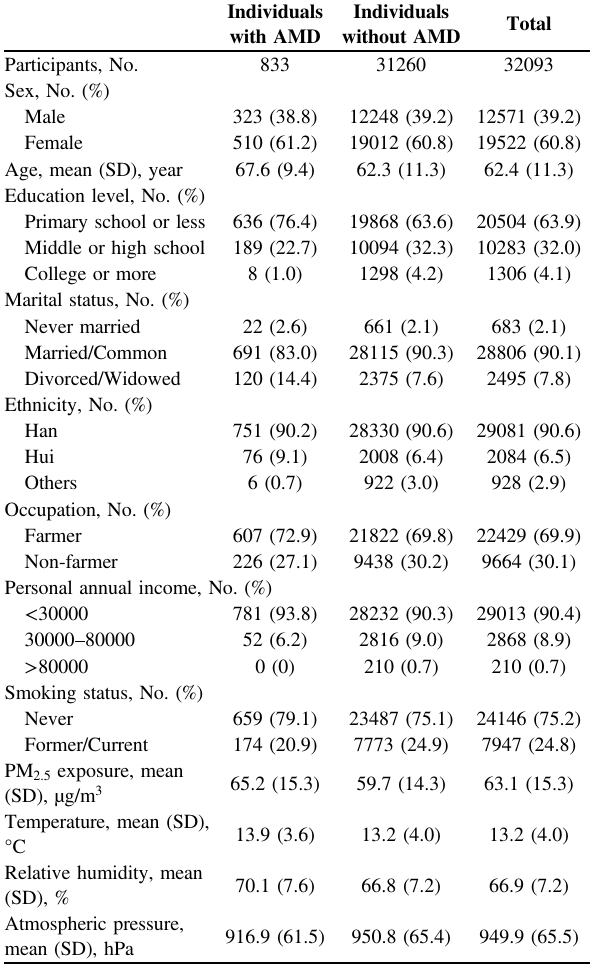
Table 1 Baseline characteristics of case and control